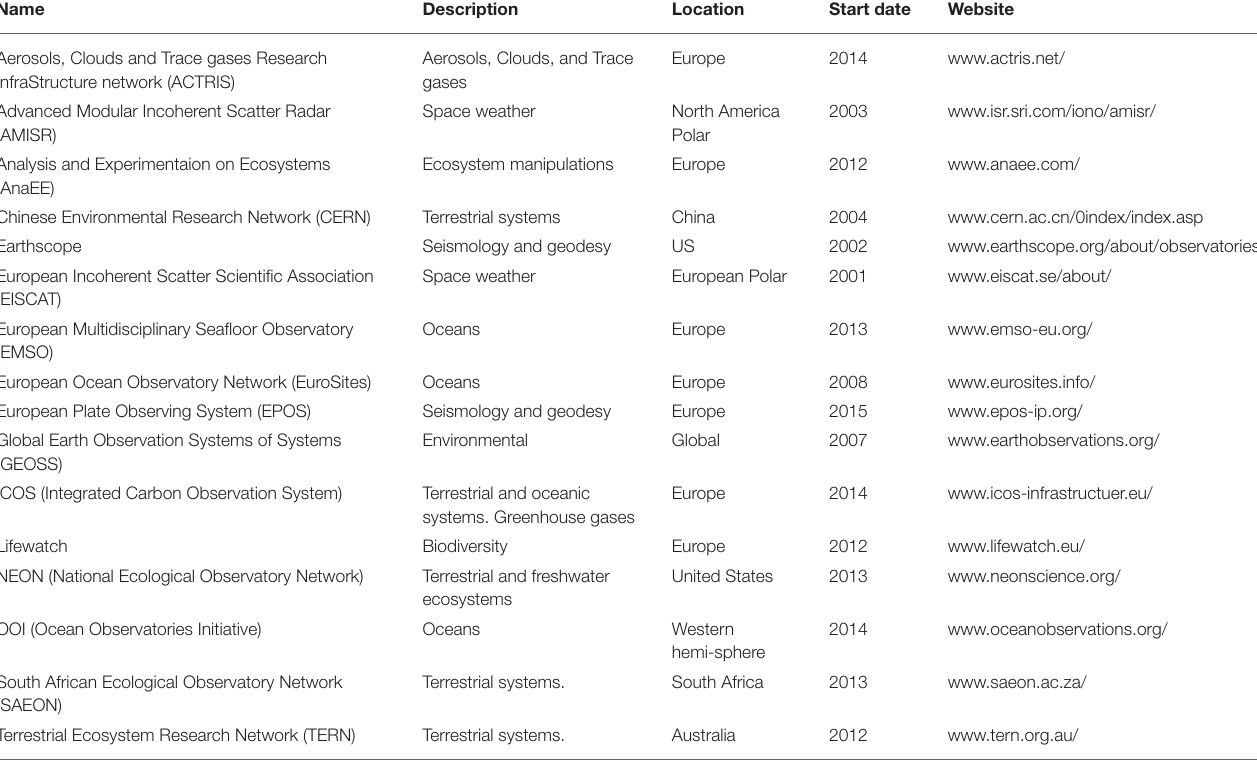
TABLE 1 | Environmental Research Infrastructures (ERIs) that are borad in both temporal and spatial scale and designed to address societal challenges, e.g., Loescher et al.